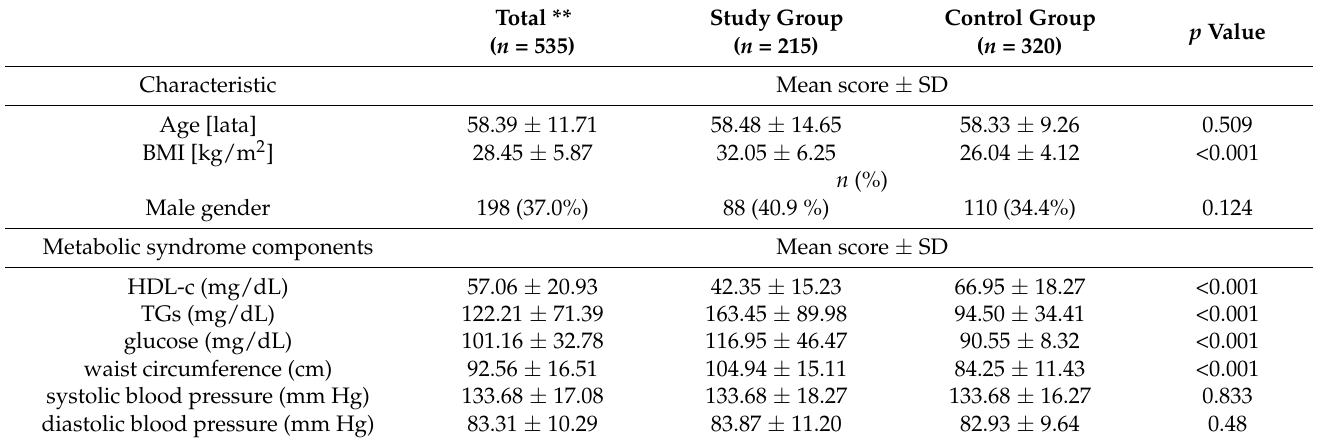
Table 1. Characteristic of participants of the study and mean metabolic syndrome components for study and control